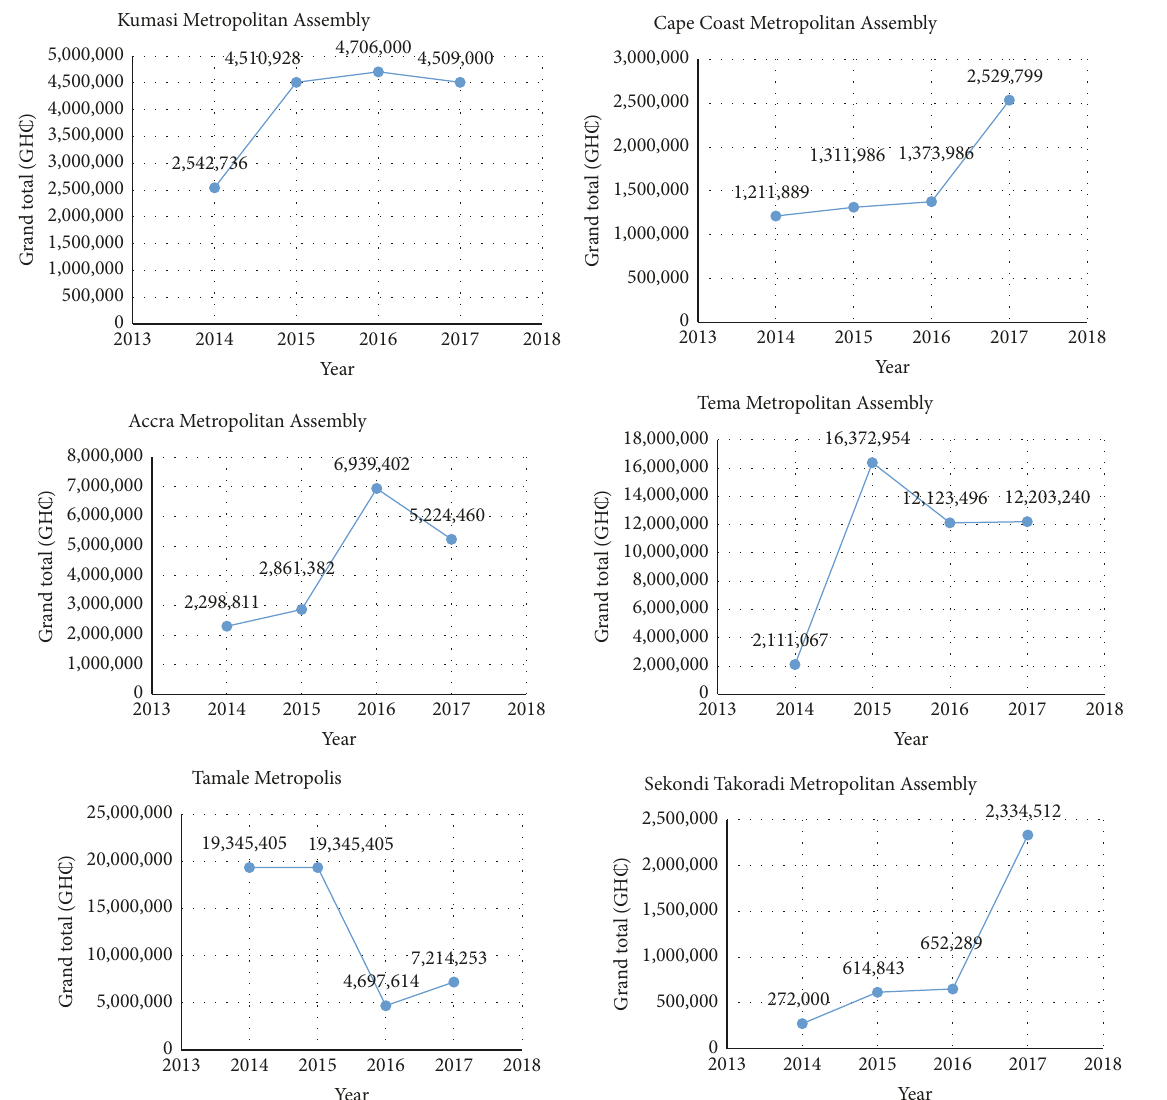
Figure 2: Line graphs showing the budgetary allocation for waste management by